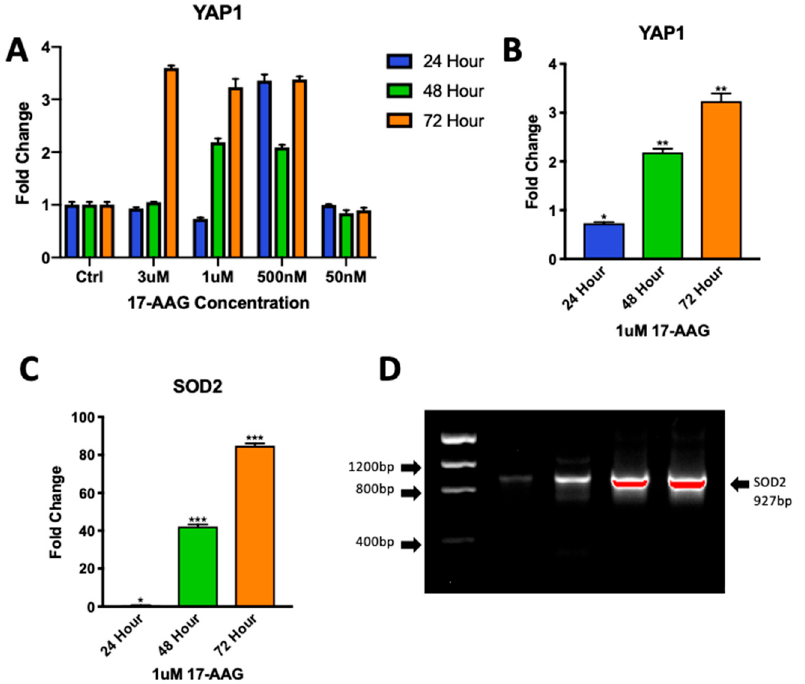
Figure 7. Adult CPCs treated with 17-AAG demonstrate upregulated YAP1 and SOD2 expression. Adult CPCs were treated with four concentrations of drug over three different time points for treatment optimization ( A ). 1 uM of drug produced the most consistent results with YAP1 expression increasing after 72 h ( B ). SOD2 expression was elevated in a similar pattern with higher fold changes ( C ). Gel electrophoresis was used to confirm the size of the SOD2 transcript ( D ). From left: Ladder, non-treated control, 24, 48, and 72 h treatment of 1uM 17-AAG. * p < 0.05, ** p < 0.01, *** p < 0.001. Fold changes are shown as the mean ± SEM. All samples were run in triplicate.